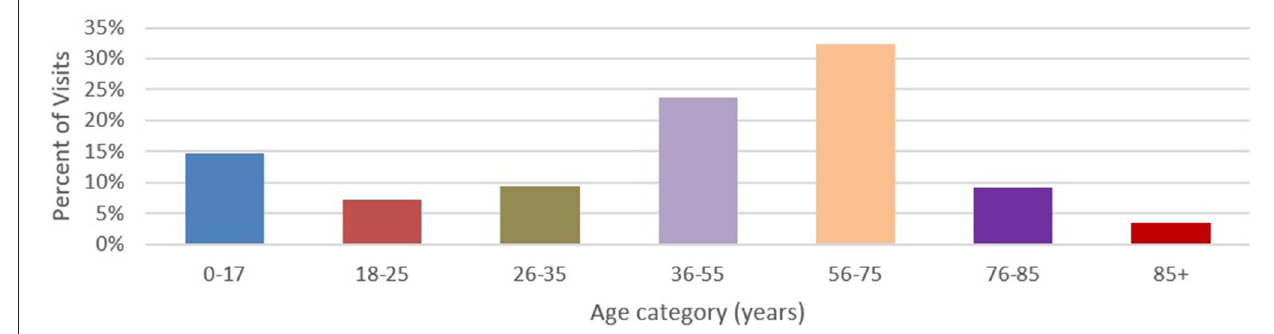
FIGURE 5 | Age categories by percent of exchange ( n = 1,492,109).